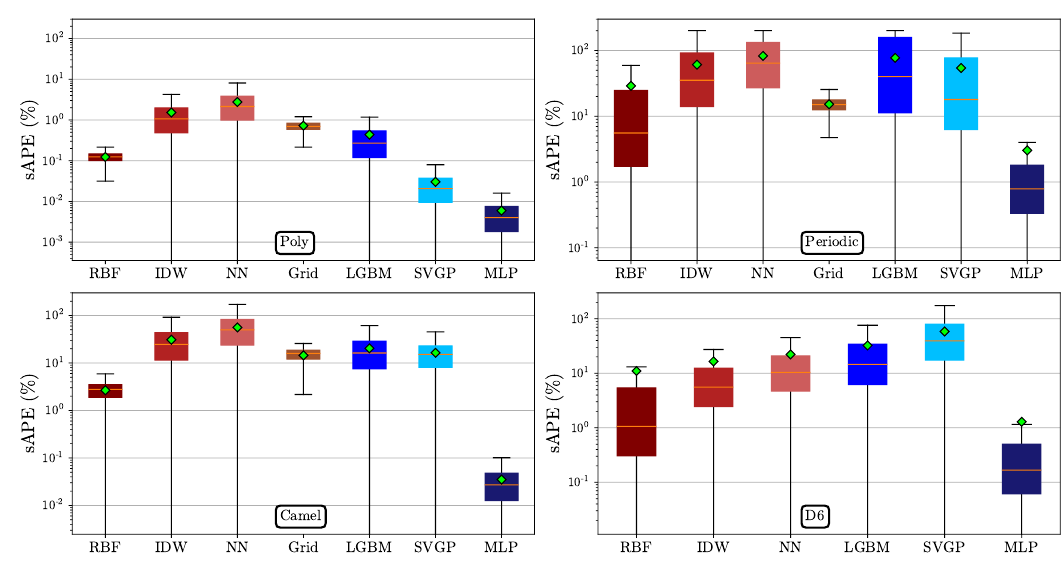
Figure 8: Boxplots of the symmetric absolute percent error (%) for four test func- tions in 6 dimensions. Red colors indicate interpolation while blue colors indicate regression methods.